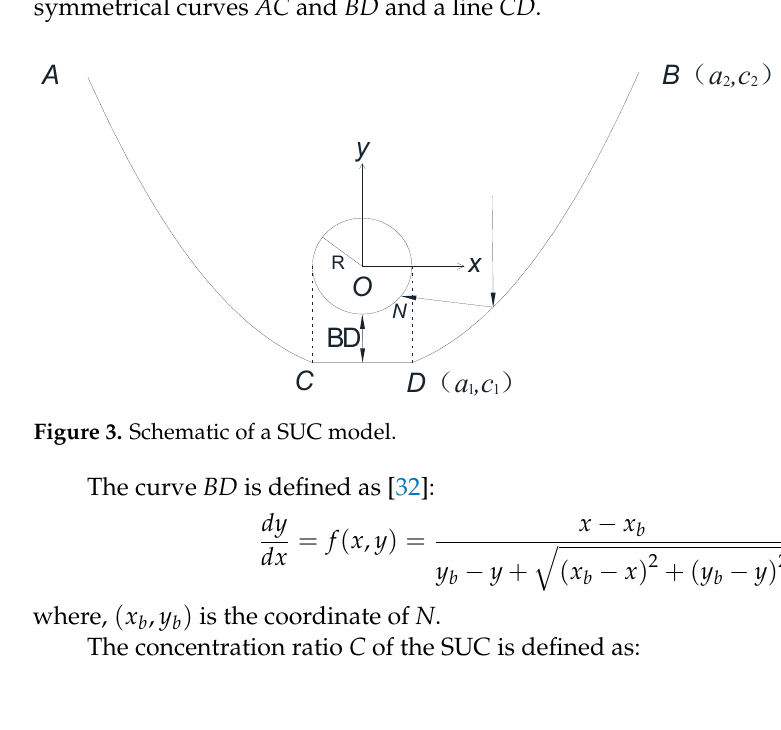
h δ R Figure 4. Schematic of a TTC model . The concentration ratio C of the TTC is defined as: 2 W C R π= (9) To identify the surface radiation distribution uniformity on the absorber tube, the uniform index U is defined, which is [32]: